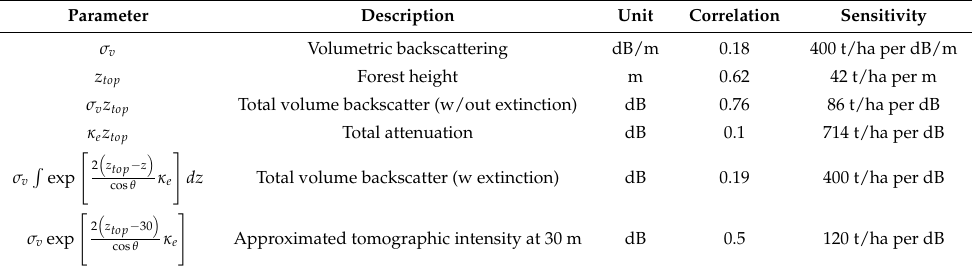
Table 1. Correlation with AGB of different parameters derived assuming the validity of Equation (2).